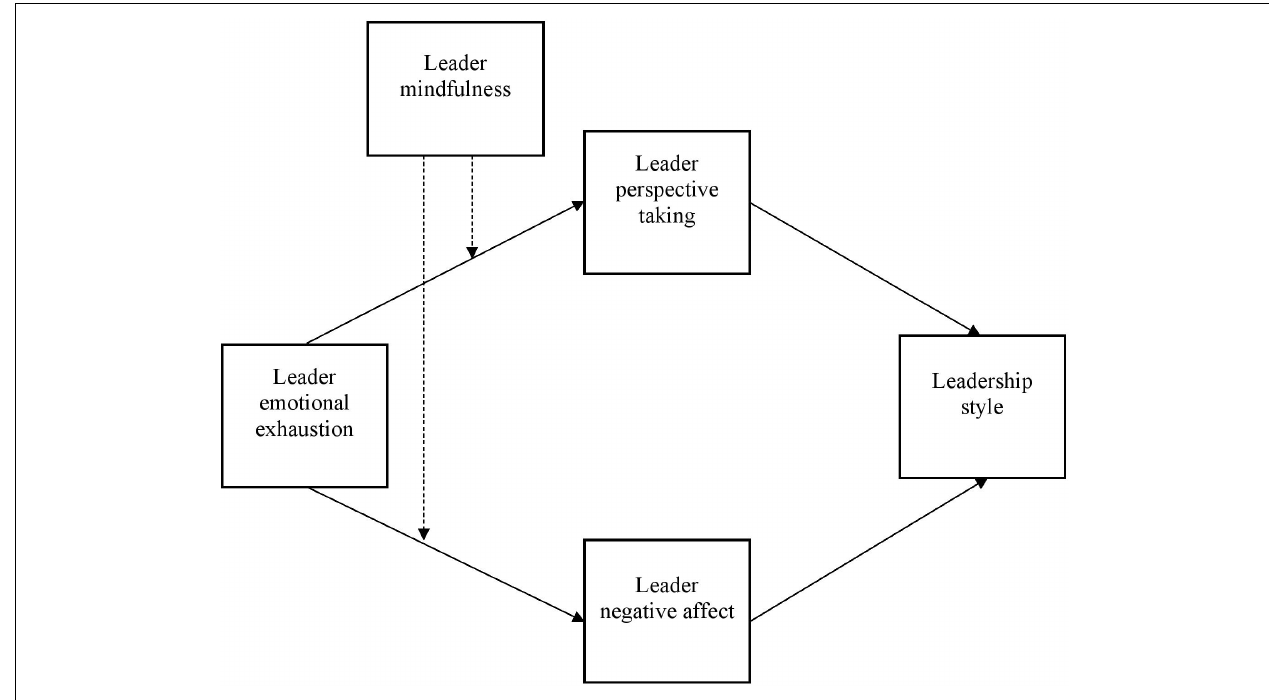
FIGURE 1 | Visual summary of hypothesized